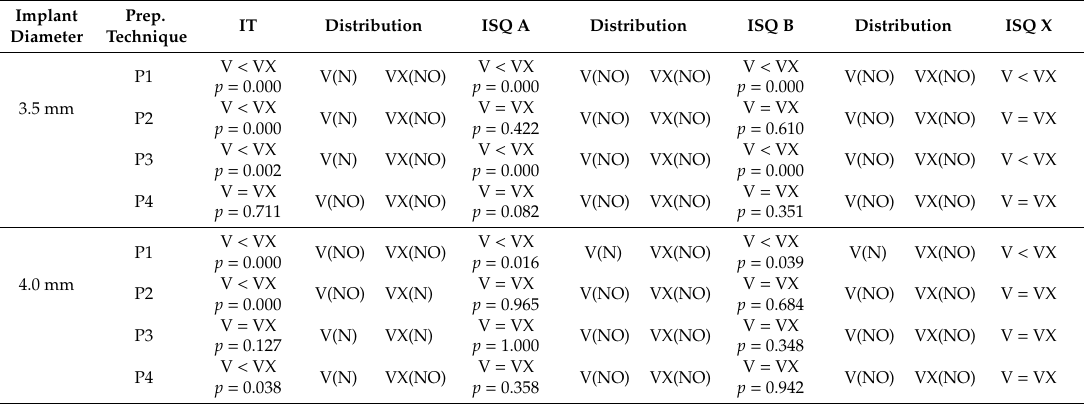
Table 2. Statistical analysis comparing the Insertion Torque (IT) and Implant Stability Quotient (ISQ) for the two implant designs in the di ff erent types of preparation (Prep. Technique) for 3.5 mm and 4.0 mm (P1 to P4 see Section 2.6 Study Groups ). Distribution ISQ